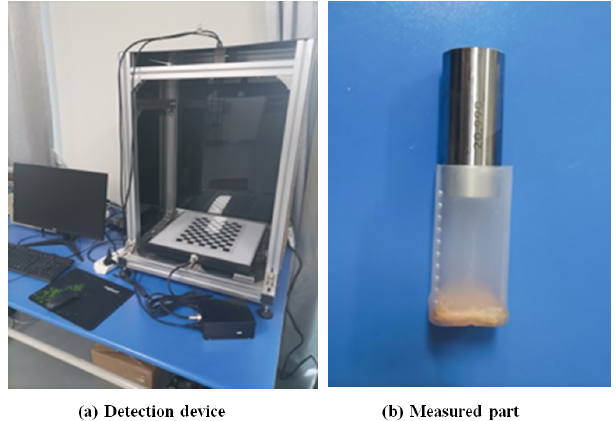
Figure 6. Visual roundness error detection.